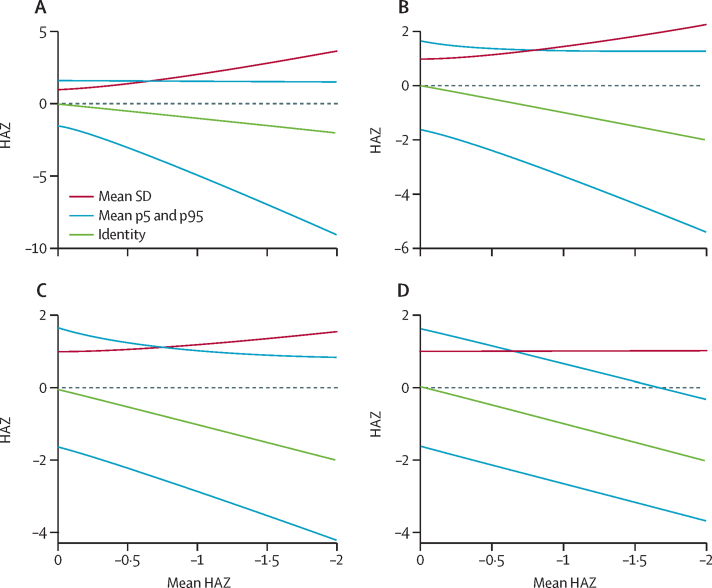
Simulations to demonstrate the theoretical effect of a set of growth-limiting exposures on standard deviation, fifth percentile, and 95th percentile of HAZ distribution for a simulated population of 10 000 children with an initial mean HAZ=0 and SD=1(A) 25% of the population exposed; average standard deviation when mean HAZ=–2 was 3·63. (B) 50% of the population exposed; average standard deviation when mean HAZ=–2 was 2·25. (C) 75% of the population exposed; average standard deviation when mean HAZ=–2 was 1·55. (D) 100% of the population exposed; average standard deviation when mean HAZ=–2 was 1·02. Monte Carlo simulation (1000 repetitions) was used to simulate a faltering process in which the mean HAZ declined from 0 to −2 via cumulative 0·1 decrements in the fixed group of exposed children. Lines represent smoothed trends of the average standard deviation, 5th percentile, and 95th percentile. HAZ=height-for-age mean Z score.